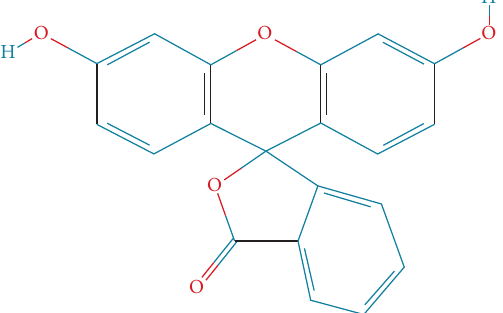
Figure 1: Chemical structure of the fluorescein (C